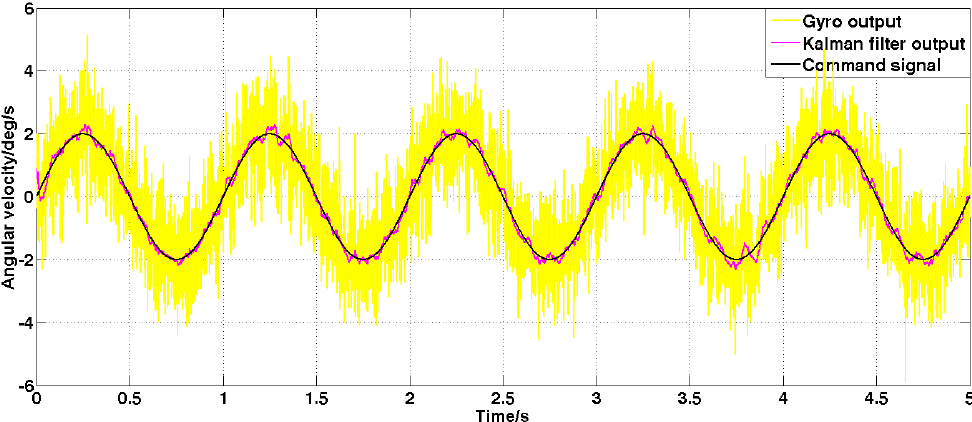
Figure 11. The angular velocity signal filtered by the Kalman algorithm under dynamic commands.